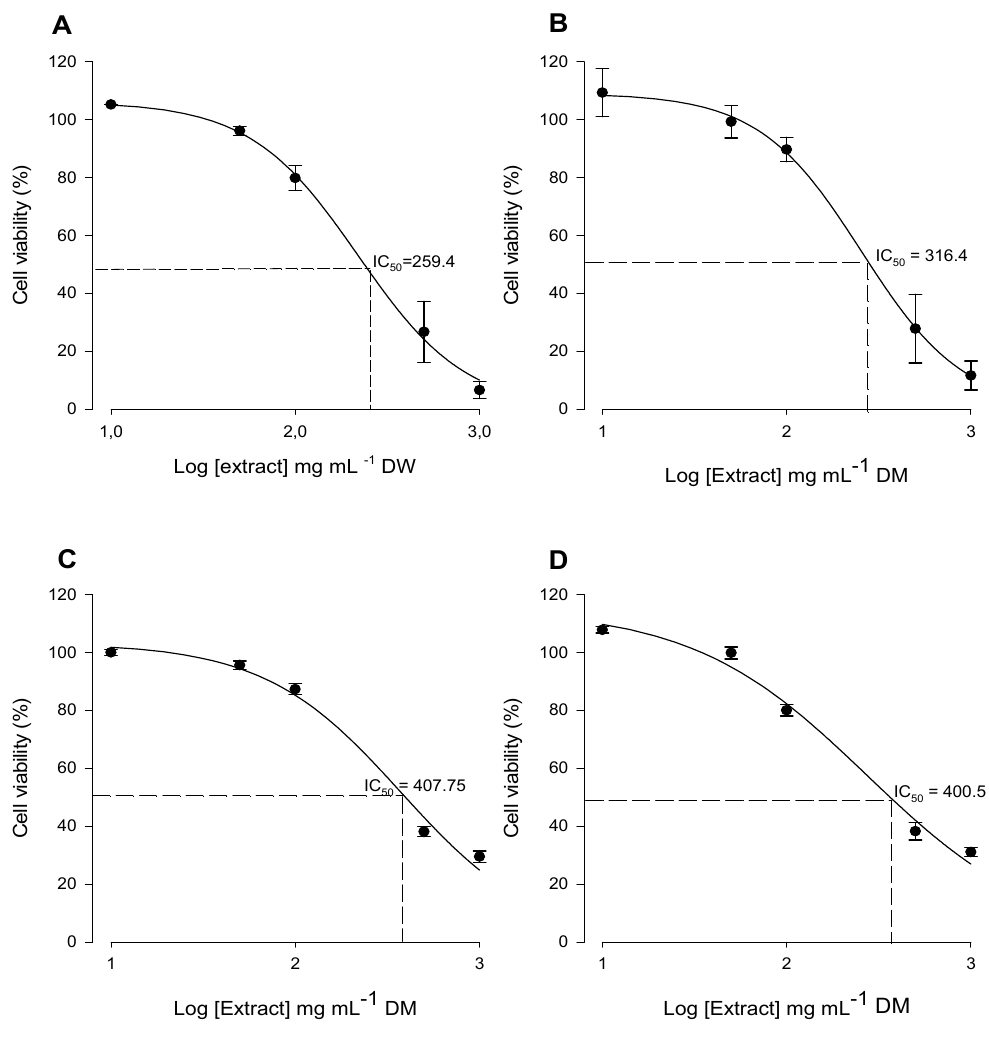
Figure 6. Dose response curve representative of the effect of GCL ( A ) green wild leaves (GWL) ( B ), dry cultivated inflorescence (DCI) ( C ) and dry wild inflorescence (DWI) ( D ) extracts on human breast cancer MDA-MB-231 cell viability. Extracts concentration range from 10 to 1000 μ g Cc mL − 1